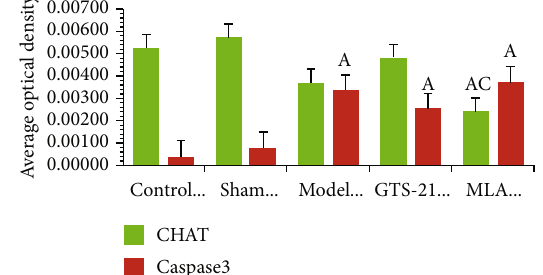
Figure 6: Cholinergic neuron apoptosis in MVZ among the di ff erent groups. The images mainly cover NST and VLRN of MVZ. DAPI: 4 ′ ,6- diamidino-2-phenylindole, a fl uorescent blue dye capable of binding strongly to DNA. CHAT: choline acetyltransferase, used for labeling cholinergic neurons (stained green with FITC); Caspase3: indicator for apoptotic cell (stained red with Cy3). The scale bars at the bottom left of the images represent 100 μ m. a: P < 0 : 05 vs. control group; c: P < 0 : 05 vs. GTS-21